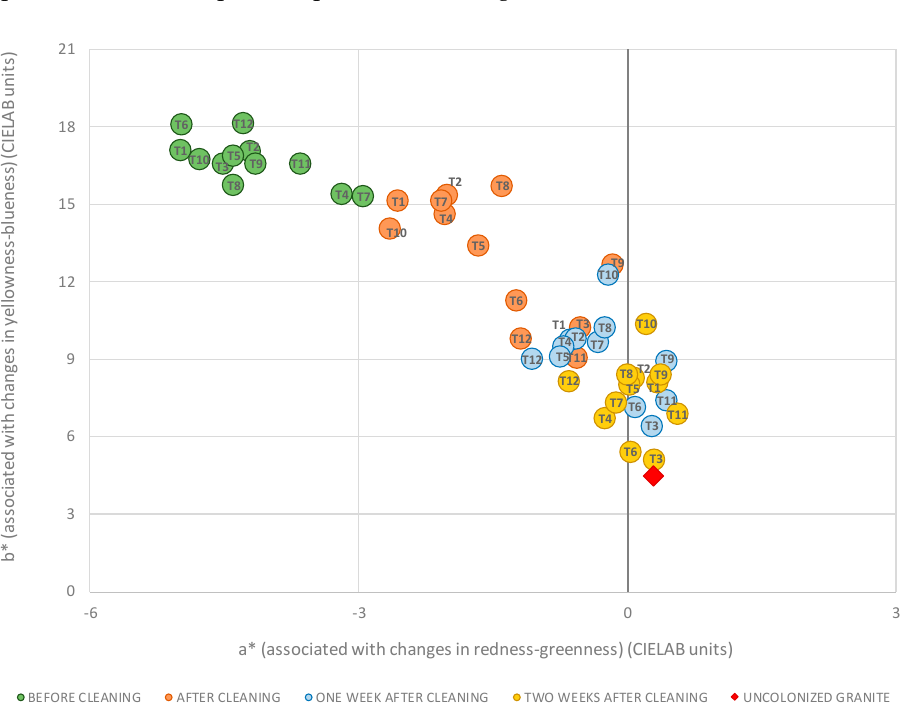
Figure 4. Color changes of the samples studied throughout the experimental period in the b* versus a* diagram. Each symbol is also identified by a sub-legend showing the sample’s treatment (codes are shown in Figure 2).